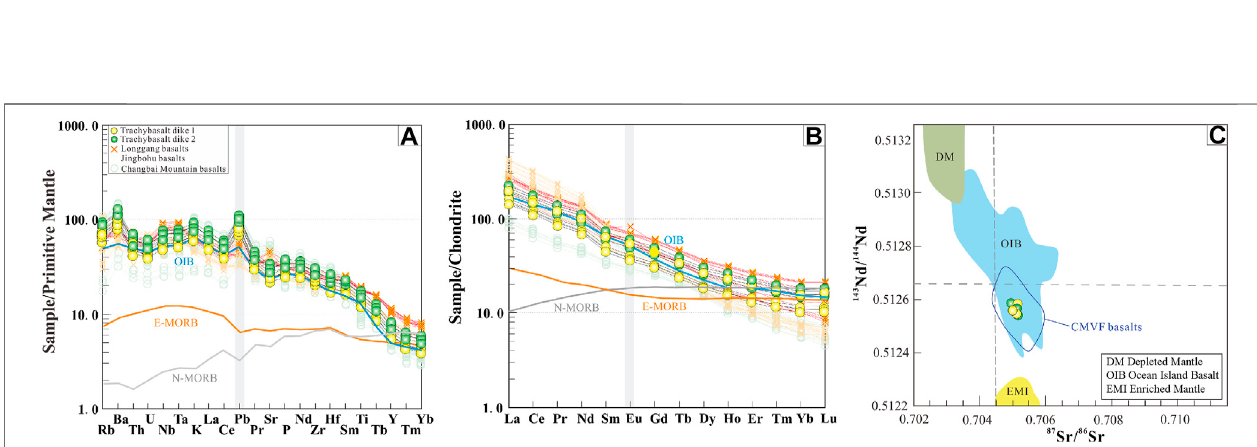
FIGURE 7 | (A) Normalized REE patterns and (B) trace element spidergrams for the trachybasaltic dike and trachybasalts in the region (Boynton, 1984; Sun and McDonough, 1989). Other data sources are as for Figure 7C ; 143 Nd/ 144 Nd versus 87 Sr/ 86 Sr plot of the CMVF trachybasalts. The fi eld of the Changbaishan basalts is from Zhang et al. (2018). Reference ranges for DM, enriched mantle (EM1 and EM2), MORB, and OIB are from Zindler and Hart (1986).